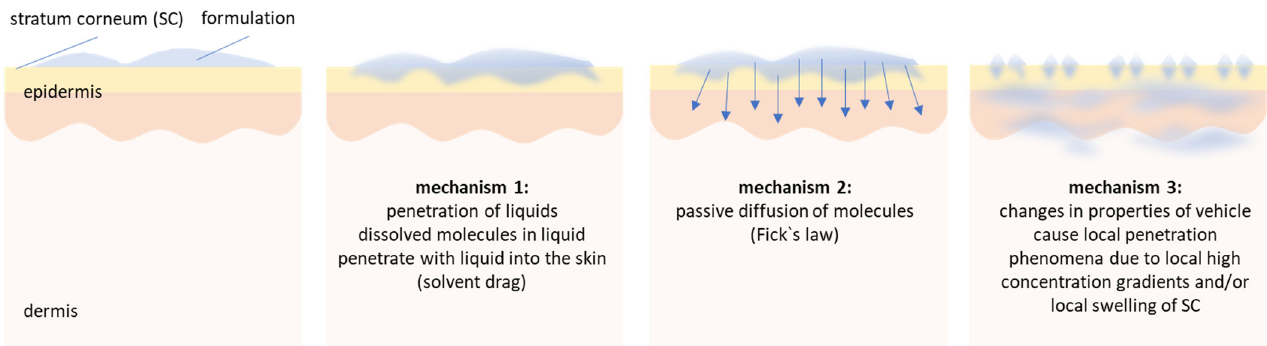
Figure 13. Proposed mechanisms of dermal penetration. 1st mechanism: penetration of low viscous liquids—active compounds penetrate via convection (solvent drag mechanisms) into the skin. 2nd mechanism: vehicle and skin are in equilibrium—AI penetrate via passive diffusion, 3rd mechanism: transformation of vehicle creates passive penetration phenomena—one example is the particle assisted penetration enhancement, i.e., the formation of aqueous menisci below particulate materials that increase the penetration of AI being dissolved in the liquid of the menisci [6]. It is likely that the different mechanisms occur not step-wise but superimpose each